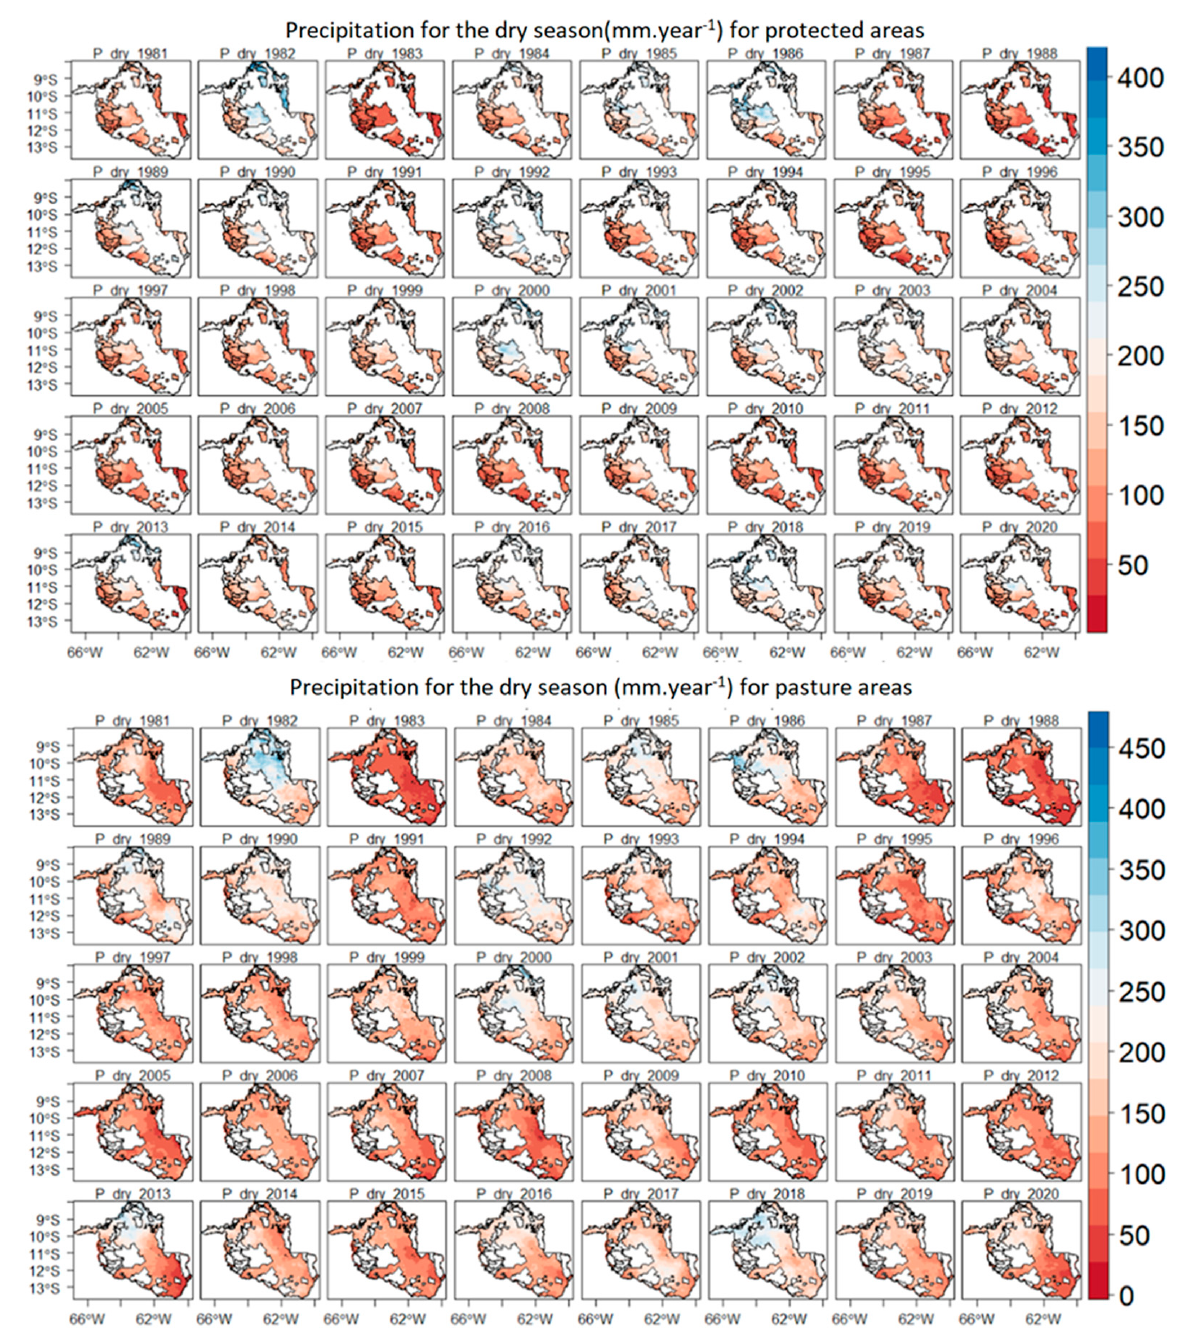
Figure 12. Spatialization of yearly accumulated rainfall for the dry season in Rondônia for the years 1981 to 2020 using CHIRPS data for protected and pasture areas.